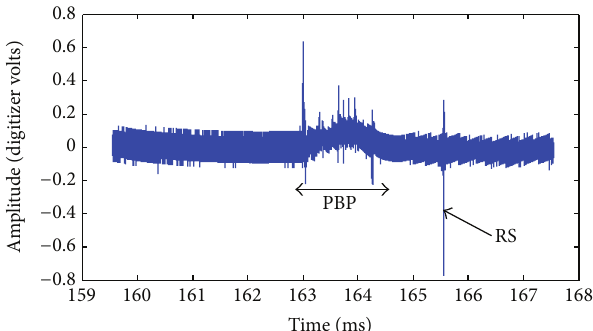
Figure 6: An example of electric field record of a positive cloud- to-ground flash happenning on 6 December 3:40:05 pm with no in- cloud discharge activity.